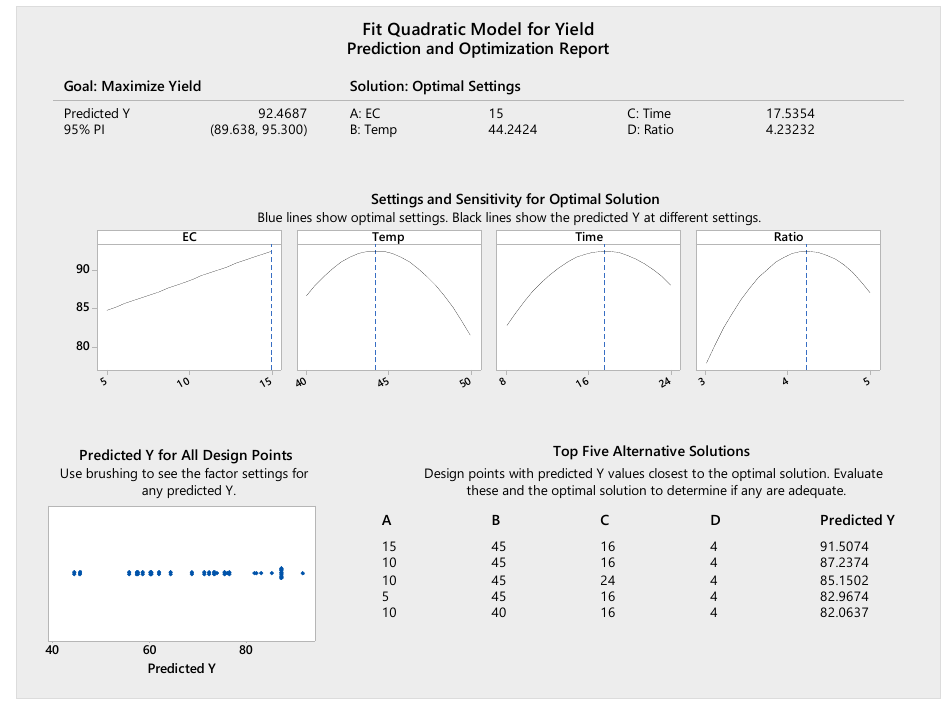
Figure 8. Prediction and optimization report for biodiesel conversion yield.